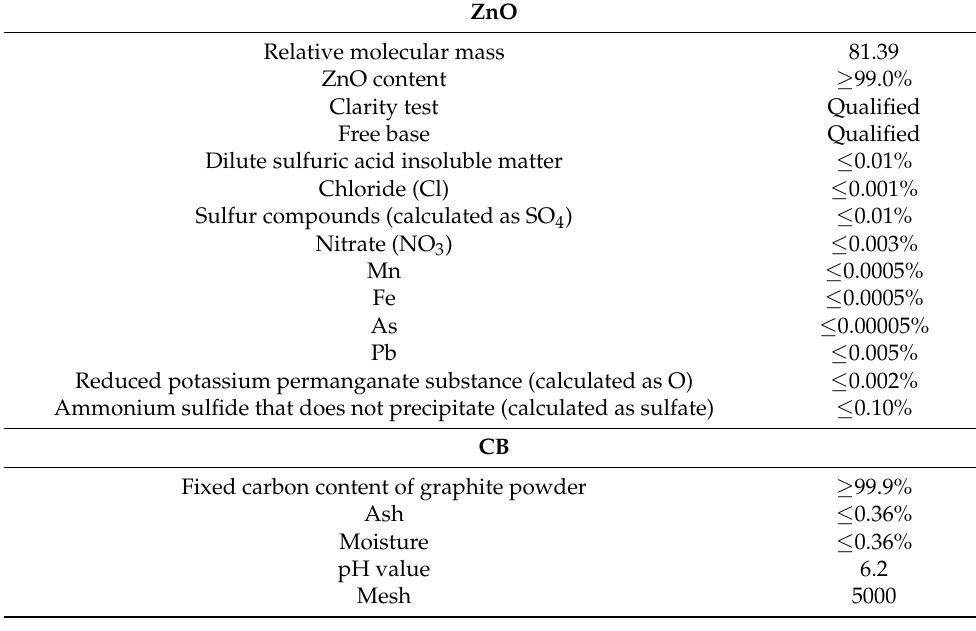
Table 1. The technical indicators of ZnO and CB.